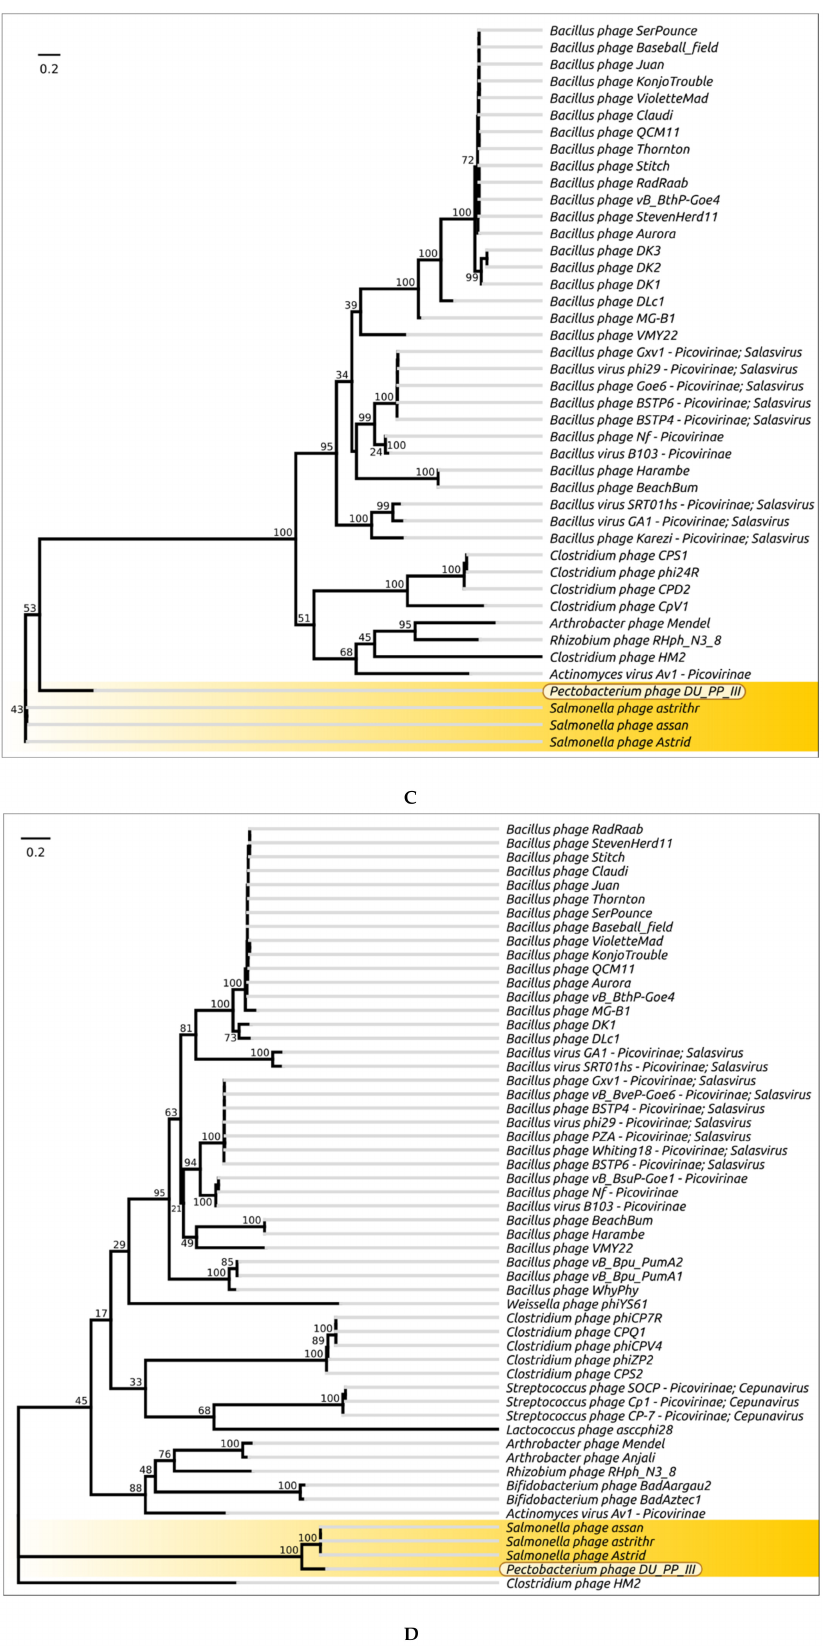
Figure 12. ( A ) . The genetic map of Pectobacterium phage DU_PP_III. The genes are coloured according to their